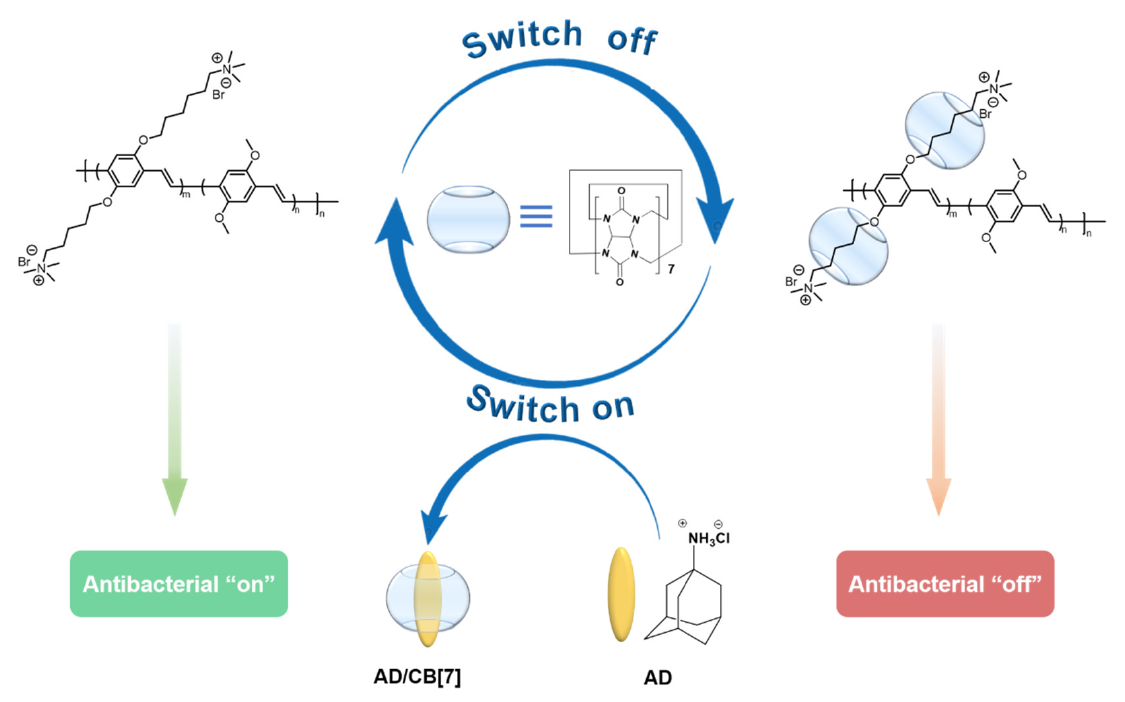
Figure 12. The supramolecular assembly process and the disassembly process of PPV/CB [7] complex.